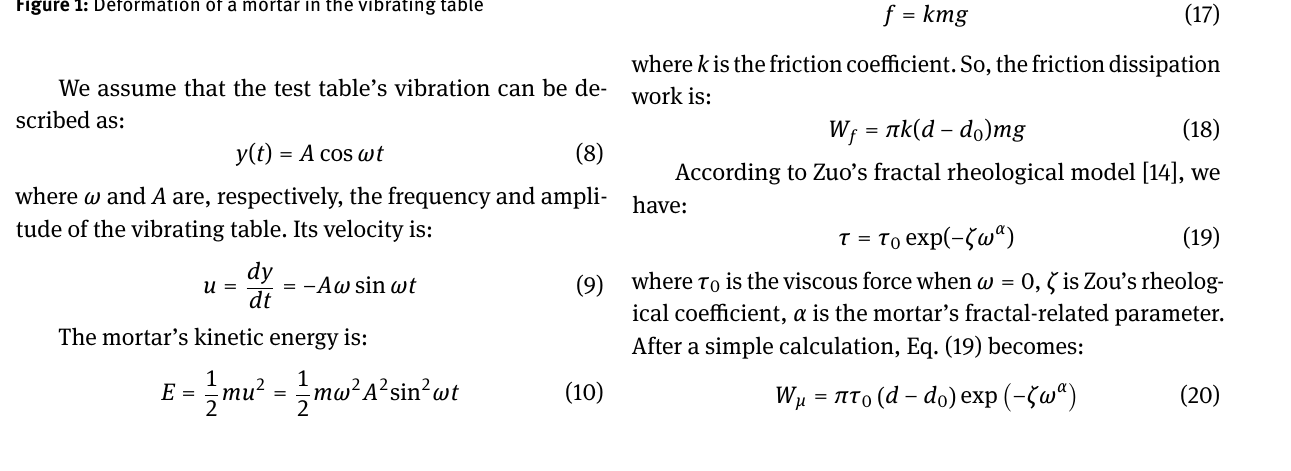
Figure 1: Deformation of a mortar in the vibrating